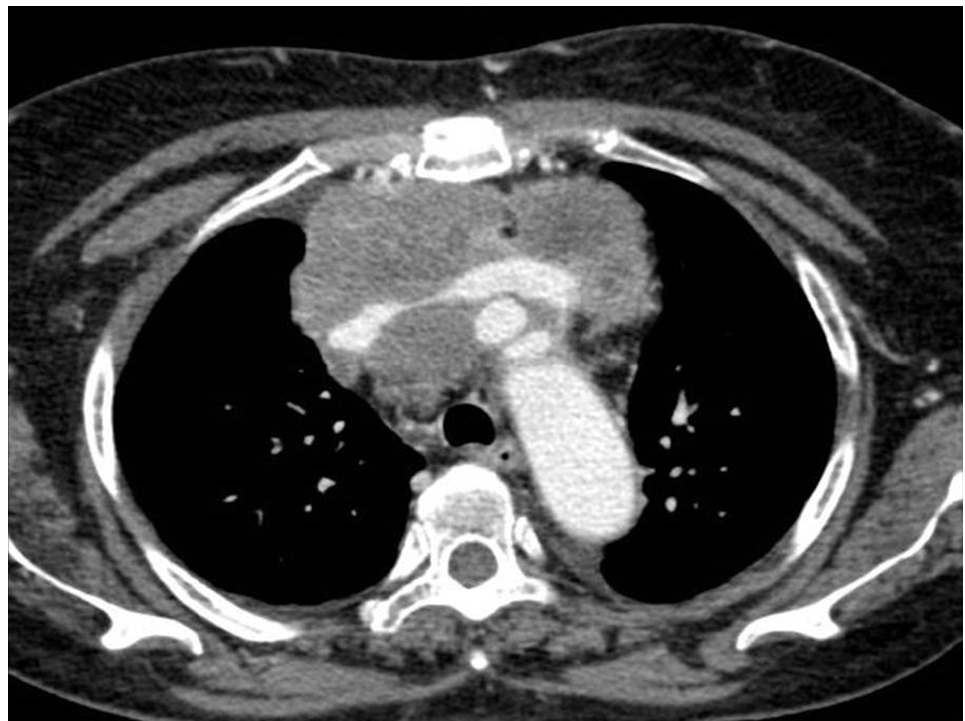
Figure 4. Malignant pleural mesothelioma mimicking a huge anterior mediastinal mass with compression of the brachio- cephalic venous trunk at the CT scan.